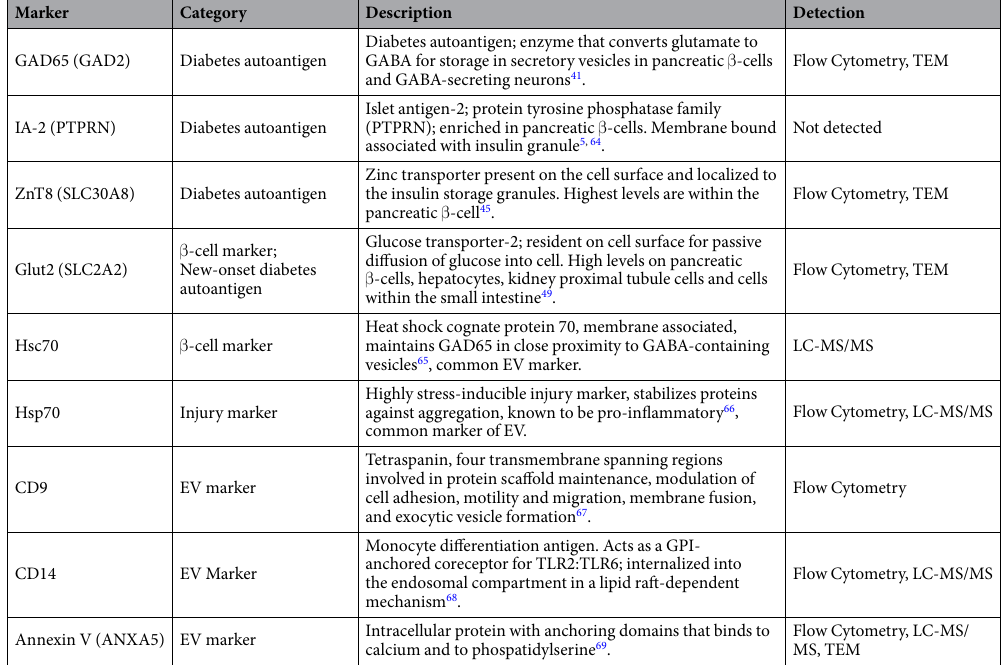
Table 2. List of autoantigens and biomarkers assessed, and the method used for their detection, within the human islet conditioned